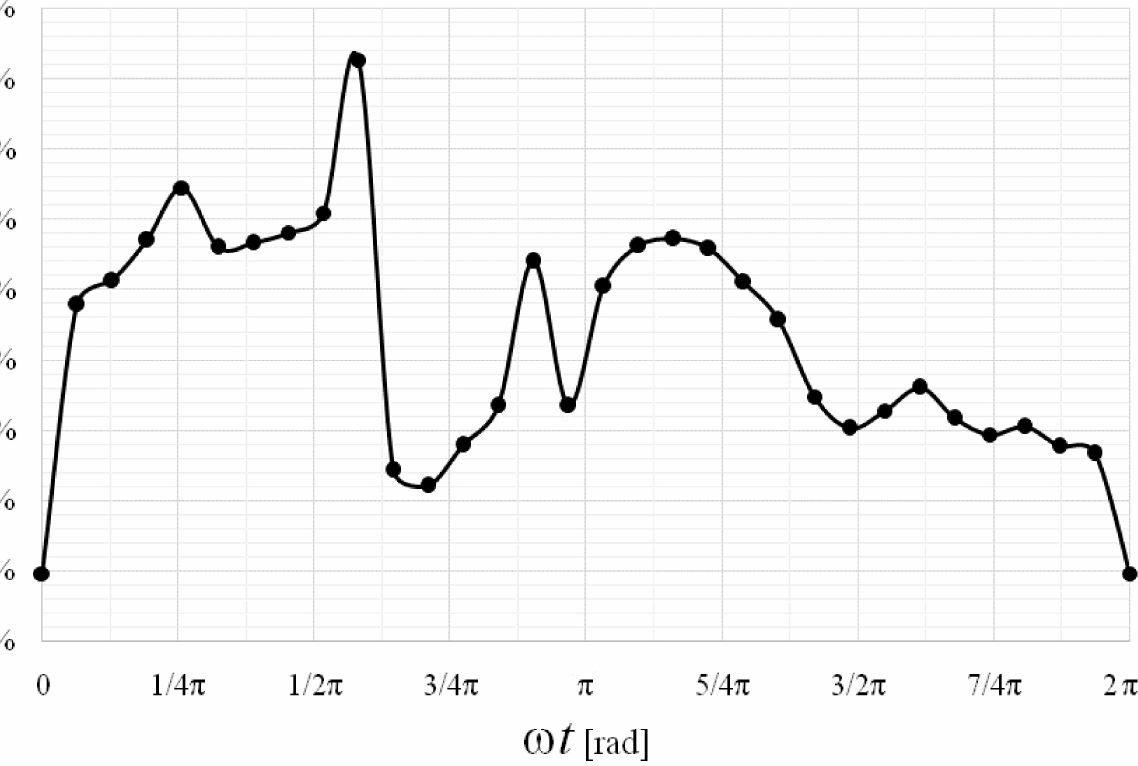
Figure 9. Values of τ for different positions of the